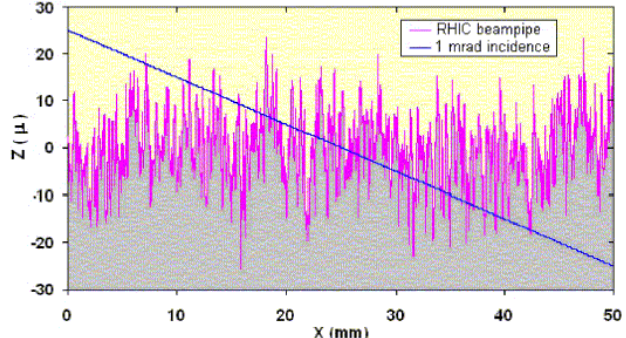
FIG. 21. (Color) Single slice of a 0 : 2 mm (cid:7) 50 mm surface scan of RHIC beam pipe material obtained by Solarius, Inc.